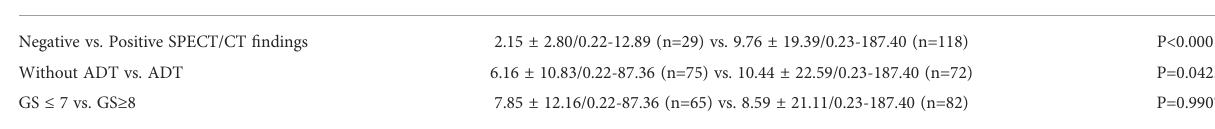
TABLE 2 The average PSA-values in this study population considering 99mTc-HYNIC-PSMA SPECT/CT results, androgen deprivation therapy, and Gleason scores.